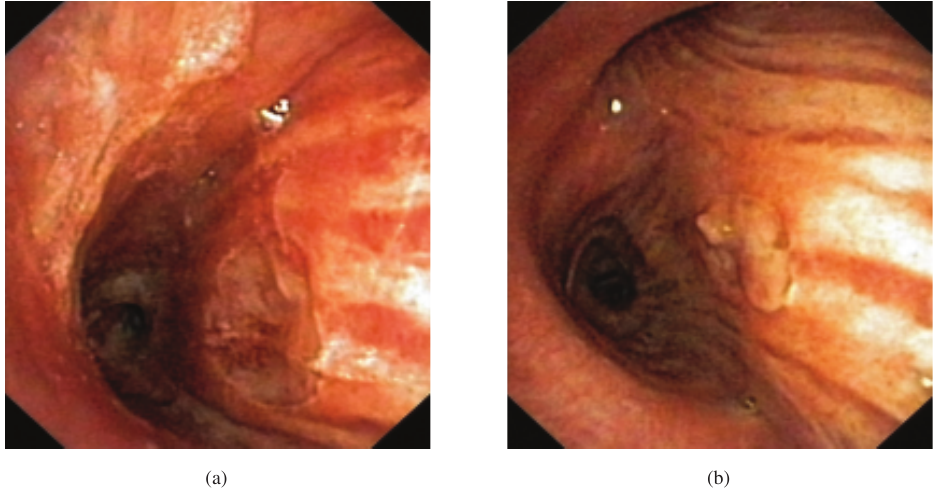
FIGURE 2: A large Aspergillus ulcer in the posterior wall of the left main stem bronchus (a). Similar ulceration in the posterior wall of the right main stem bronchus covered by fibrin and tissue debris